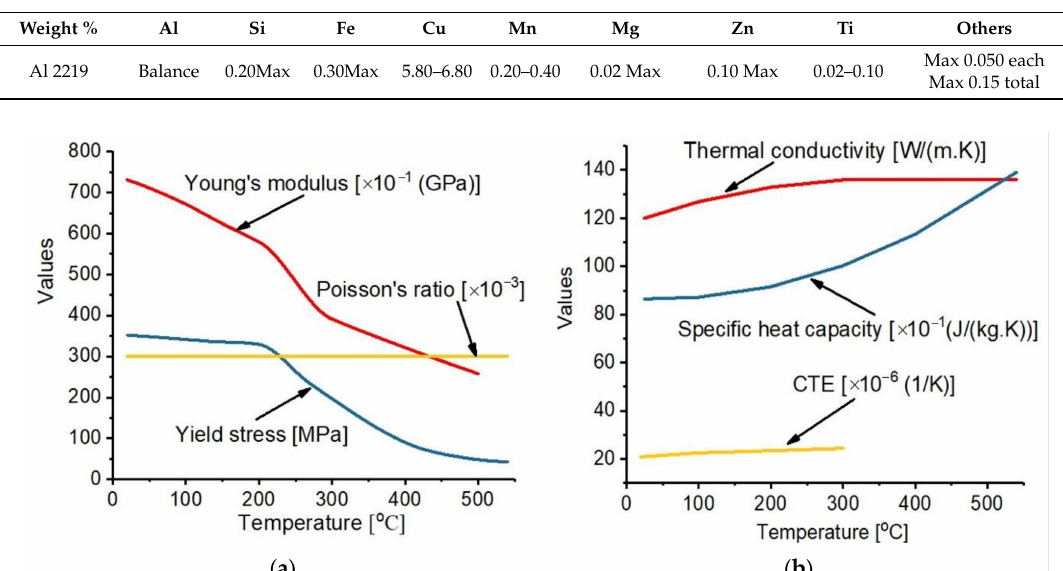
Table 1. Al 2219 composition.